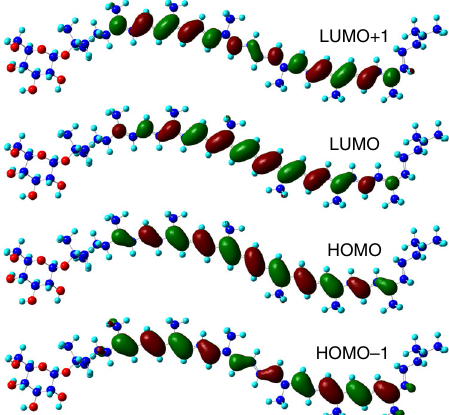
Fig. 4 Molecular orbitals of rhodopsin glucoside. The wave function isosurfaces for the highest two occupied and the lowest two unoccupied orbitals of rhodopsin glucoside. C, O, and H atoms are shown in blue , red , and cyan ,